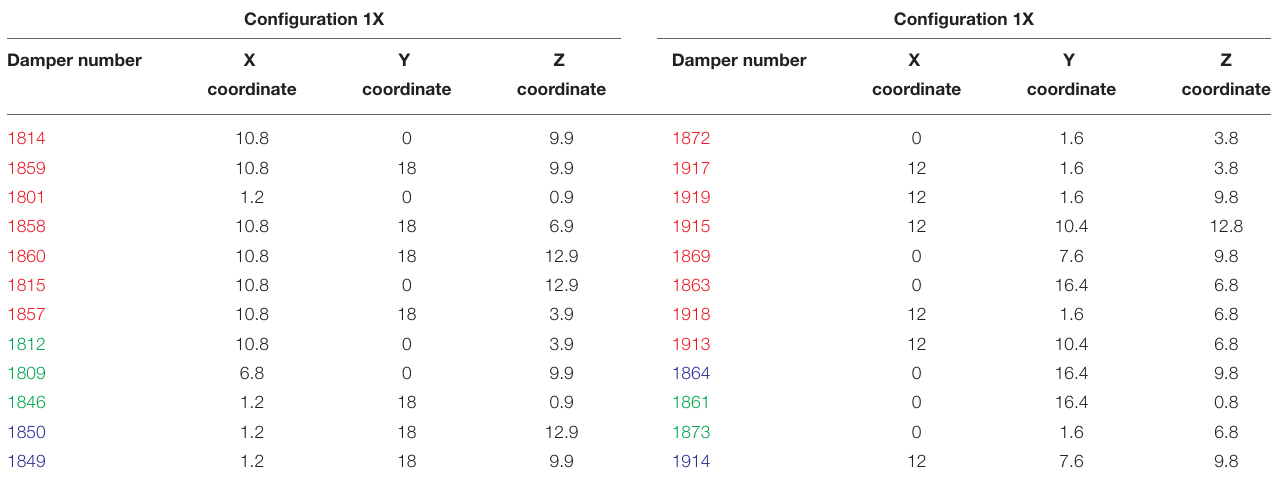
TABLE 7 | New configuration 1 in X and Y direction (fourth generation